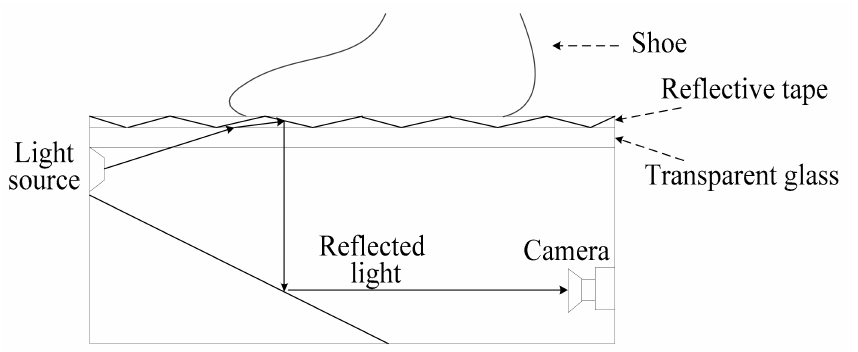
Figure 5. The imaging process of the shoeprint